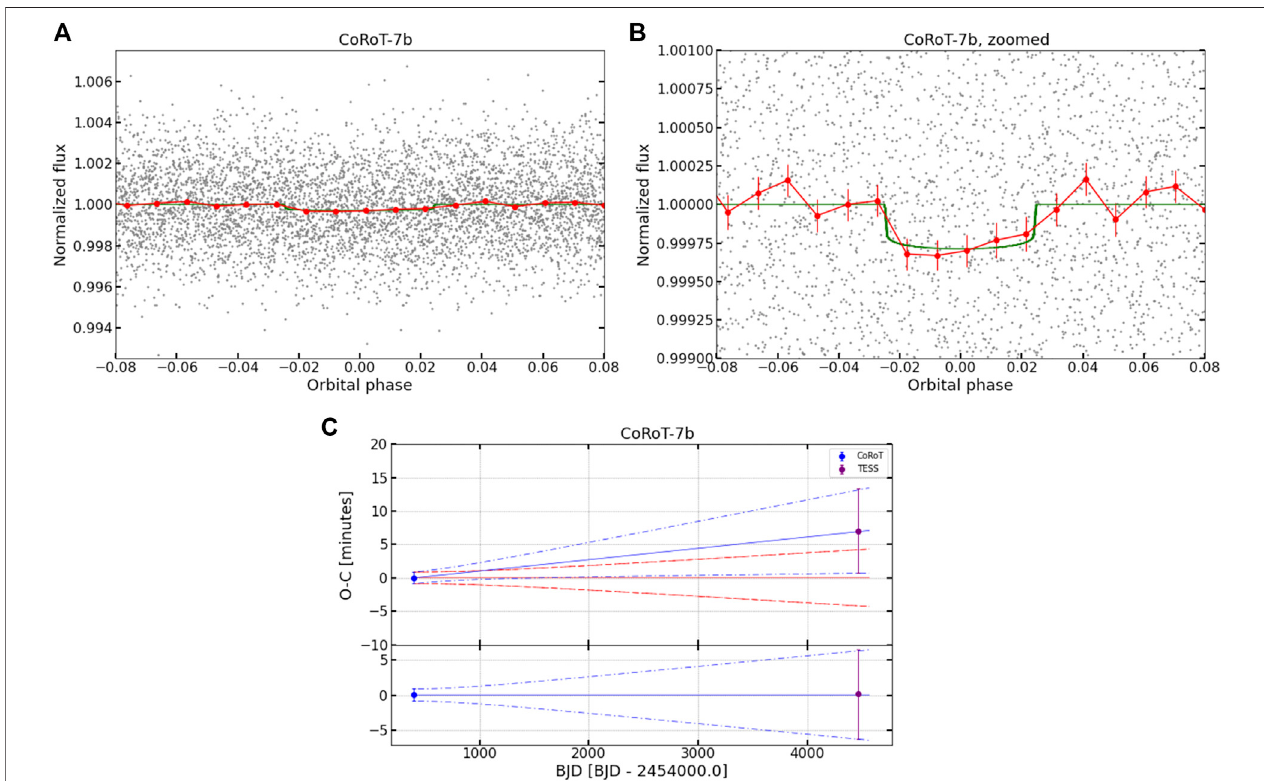
FIGURE4| CoRoT-7b (A): TESS observations and lightcurve fi t. The orbitalphase is givenagainsttheephemerisbyBarros et al.(2014) (B) : Thesameas (A) , but we zoomed in to show the 0.027 % deep transit (C): O-C diagram; the symbols and colours are the same as for Figures 1 , 2 . However, since the original ephemeris by Barros et al. (2014) is based on two separate CoRoT runs, we do not provide a standardized error for that